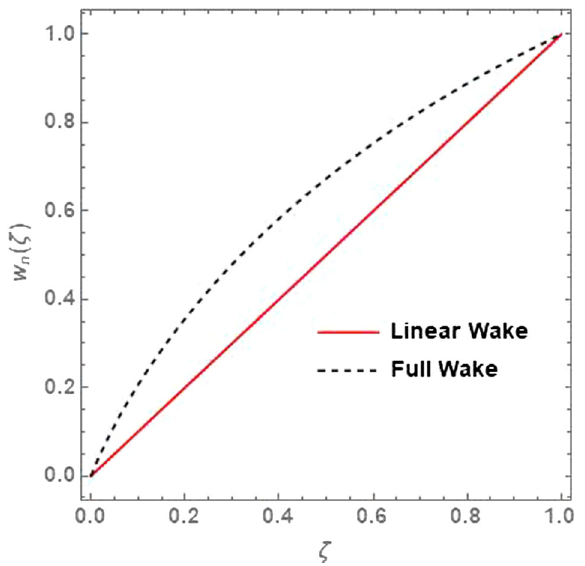
FIG. 44. Comparison between the normalized transverse wake- function for the XARA structure and the linear approximation of the